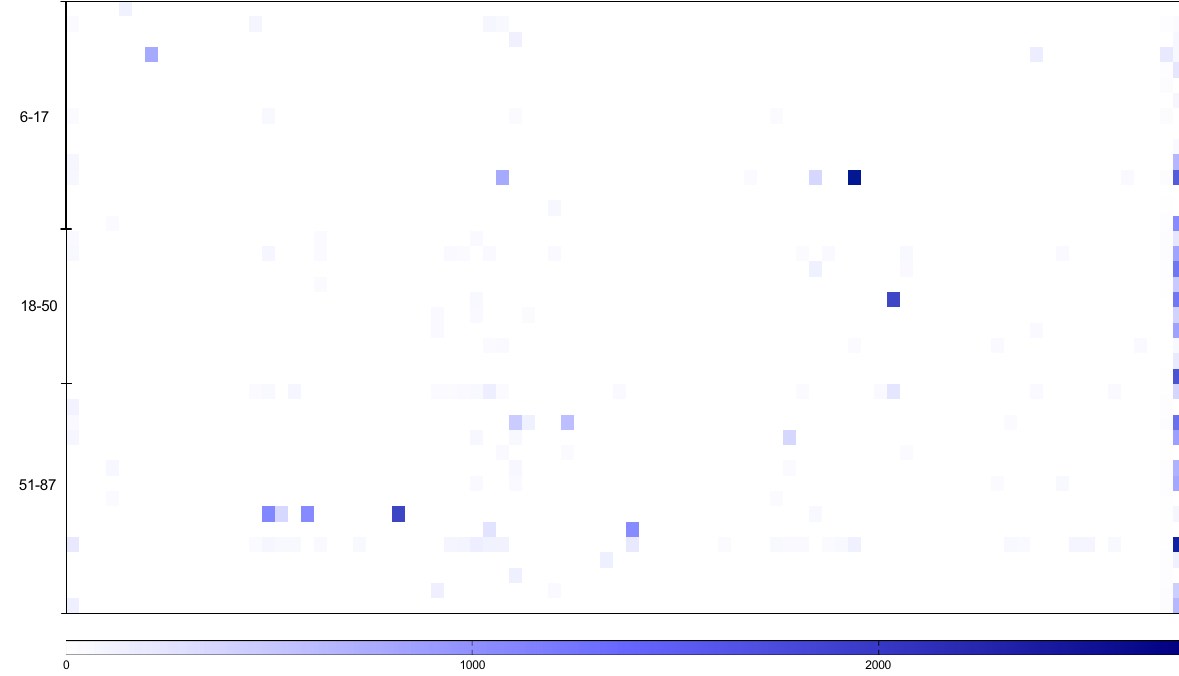
Fig. 1 KSHV-speci fi c IFN- γ responses of 40 Ugandans aged 6 – 87 years. Ex vivo ELISpot assay was used to determine IFN- γ responses to KSHV overlapping peptide pools. Spot forming cells (SFC) per million PBMCs were recorded for each reaction. The intensity of the purple colour correlates with the number of SFC per million PBMCs. The raw data used to draw this graph are shown in Supplementary Data 2. SIV Simian immunode fi ciency virus, CEF CMV + EBV + fl u cocktail, EBV Epstein – Barr virus. Heatmap drawn in GraphPad Prism version 8.0.1. Source data are provided as a Source Data fi